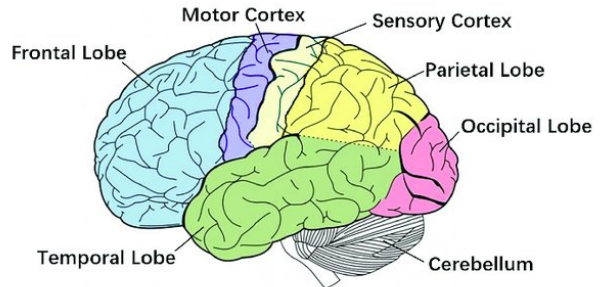
Figure 1. The human brain [3], under CC by 4.0.